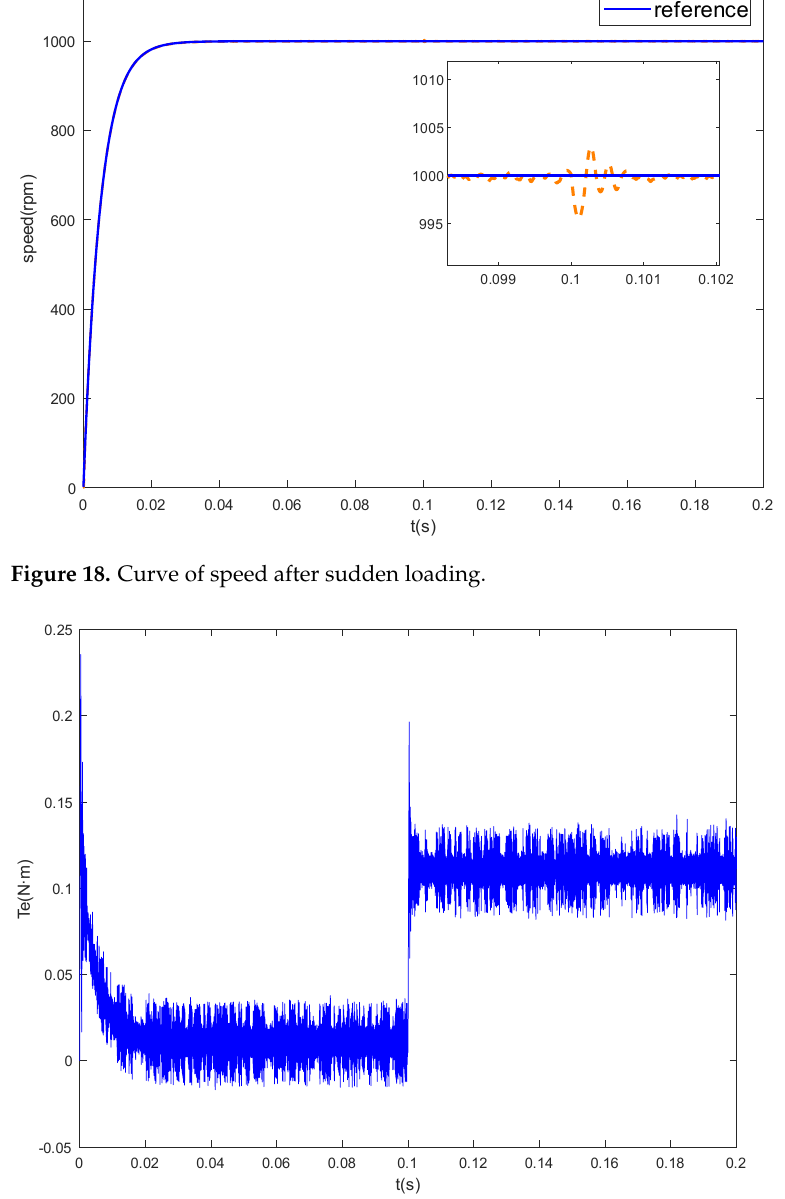
Figure 19. Curve of torque for sudden loading.